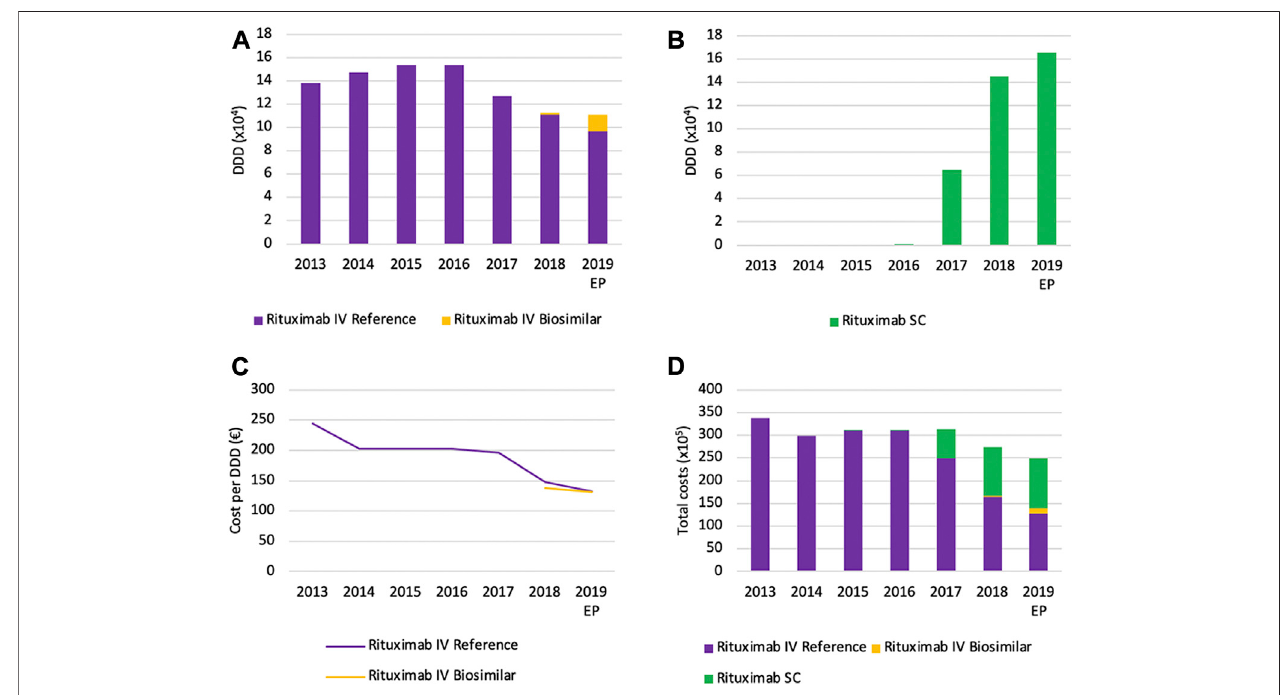
FIGURE 11 | Market data evolution of rituximab between 2013 and 2019. Total volume (DDD) evolution of IV rituximab (A) ; Total volume (DDD) evolution of SC rituximab (B) ; Daily cost ( € per DDD) of IV rituximab (C) ; Total cost ( € ) evolution of rituximab (D) . EP: Extrapolated data.